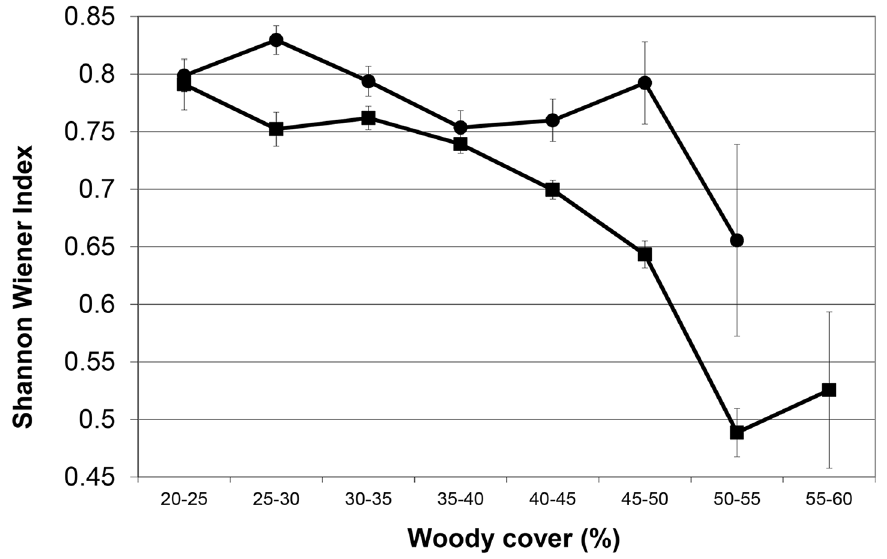
Fig 4. Shannon Wiener Diversity Index along a woody cover gradient. (basalts: circles; granites: squares) (standard error bars included). Note how with increasing woody cover the diversity index decrease, with highly significantly negative slope coefficients (basalt: -0.0025 (p = 0.005; n = 3570); granite: -0.0078 (p < 0.0001; n = 8682)).